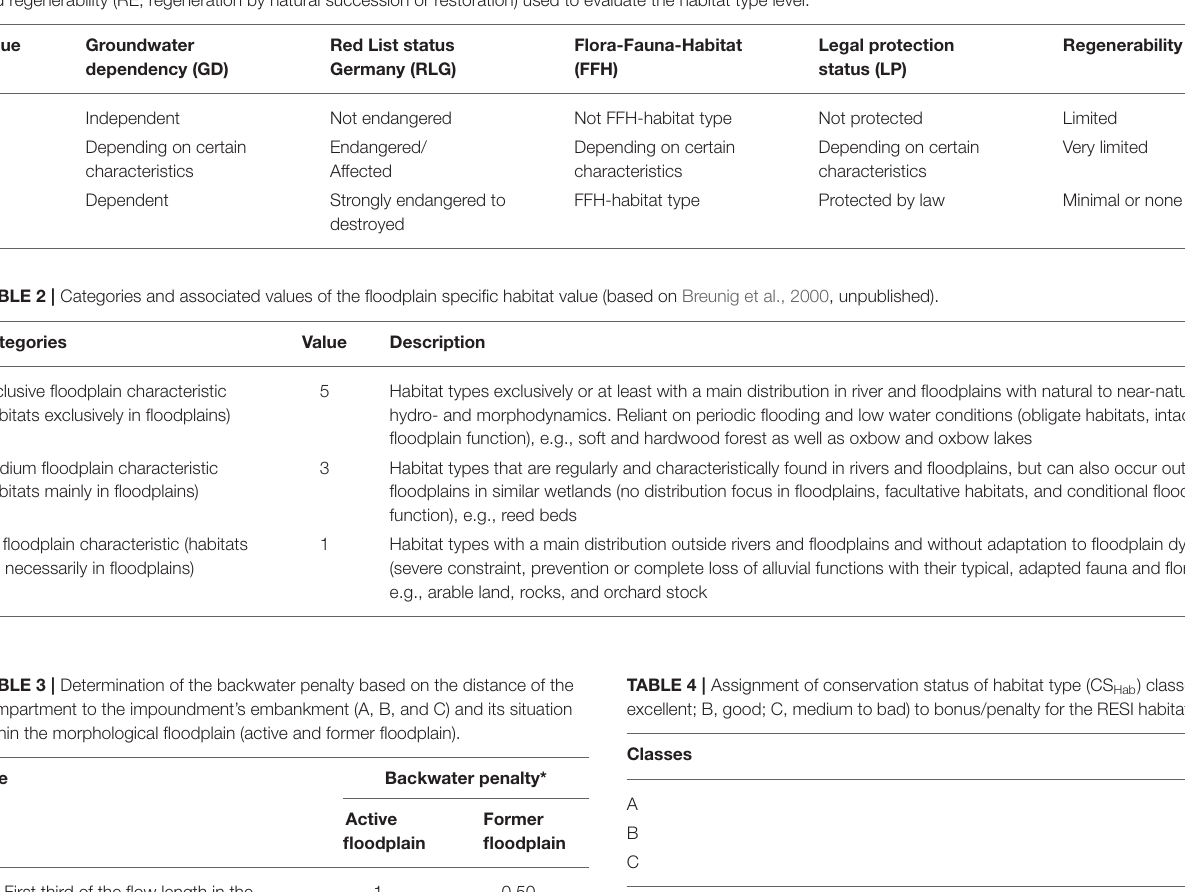
TABLE 1 | Values and categories of the criteria (groundwater dependence (GD), Red List status Germany (RLG), “Fauna-Flora-Habitat” (FFH), legal protection status (LP), and regenerability (RE, regeneration by natural succession or restoration) used to evaluate the habitat type level.